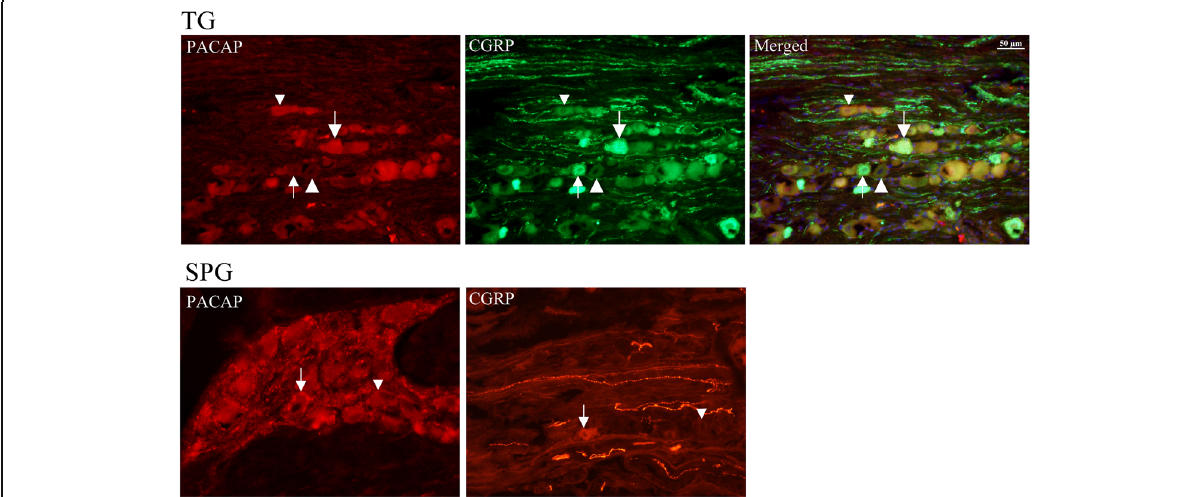
Fig. 1 Immunohistochemical demonstration of distribution of PACAP and CGRP in the sphenopalatine ganglion (SPG) and the trigeminal ganglion (TG). The figures illustrates that in both ganglia there are cells storing the two neuropeptides and also being alone. The CGRP immunoreactivity occurs more frequent in the TG than does PACAP-ir. Arrows show CGRP positive and PACAP negative cells, while arrow heads show co-localization (above) or negative (below). There are also fibers positive to CGRP. In the SPG the arrow shows a single CGRP positive cell that co-localize PACAP while numerous cells are positive to PACAP only (arrow head). In the right hand SPG illustration there are several CGRP positive